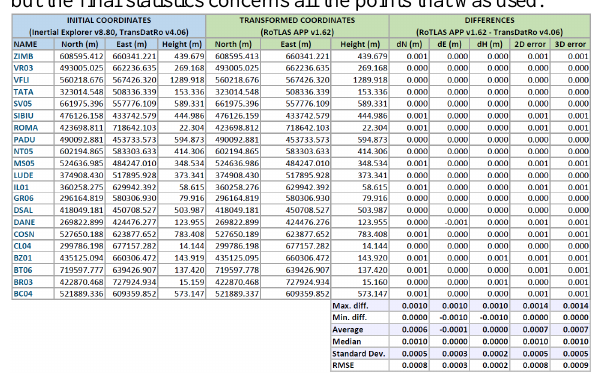
Table 2 . Validation statistics for transformation from UTM 35N